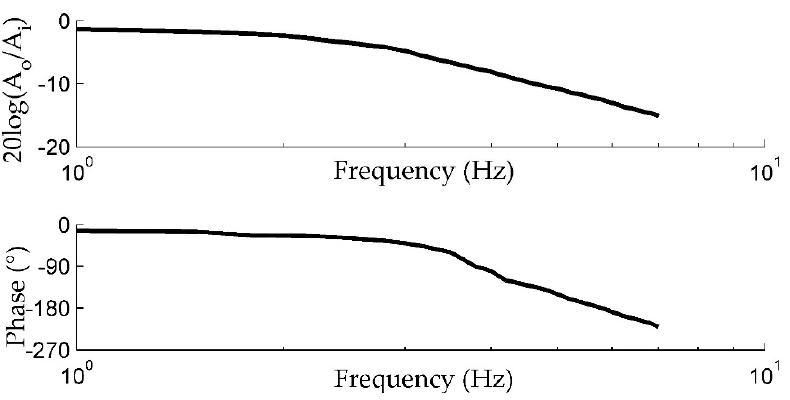
Figure 17. The frequency response of the closed-loop actuator.